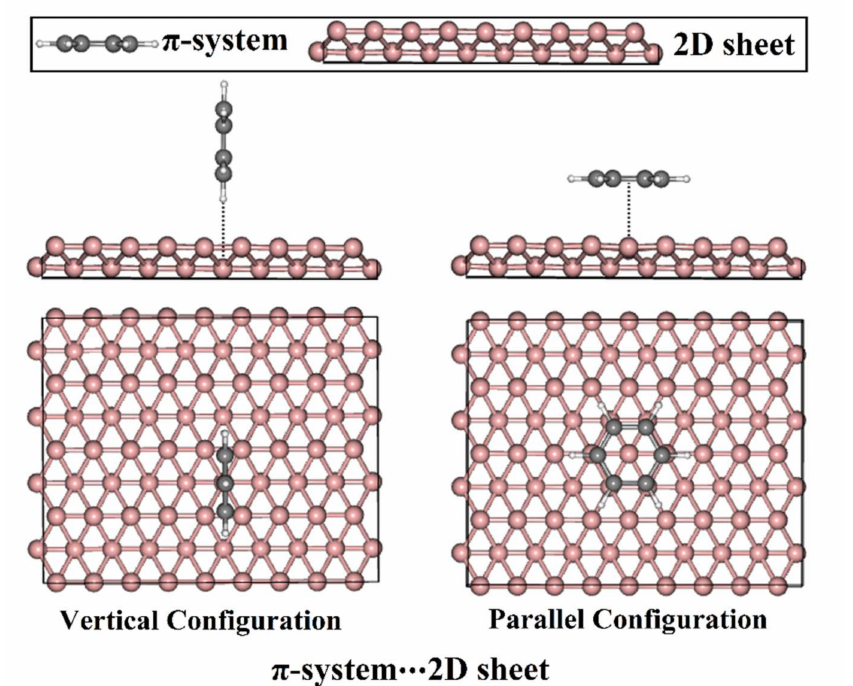
Figure 1. Side and top views of the vertical and parallel configurations of the π -system ··· 2D sheet complexes where π -system = BNZ/HFB and the 2D sheet = sB/ β 12